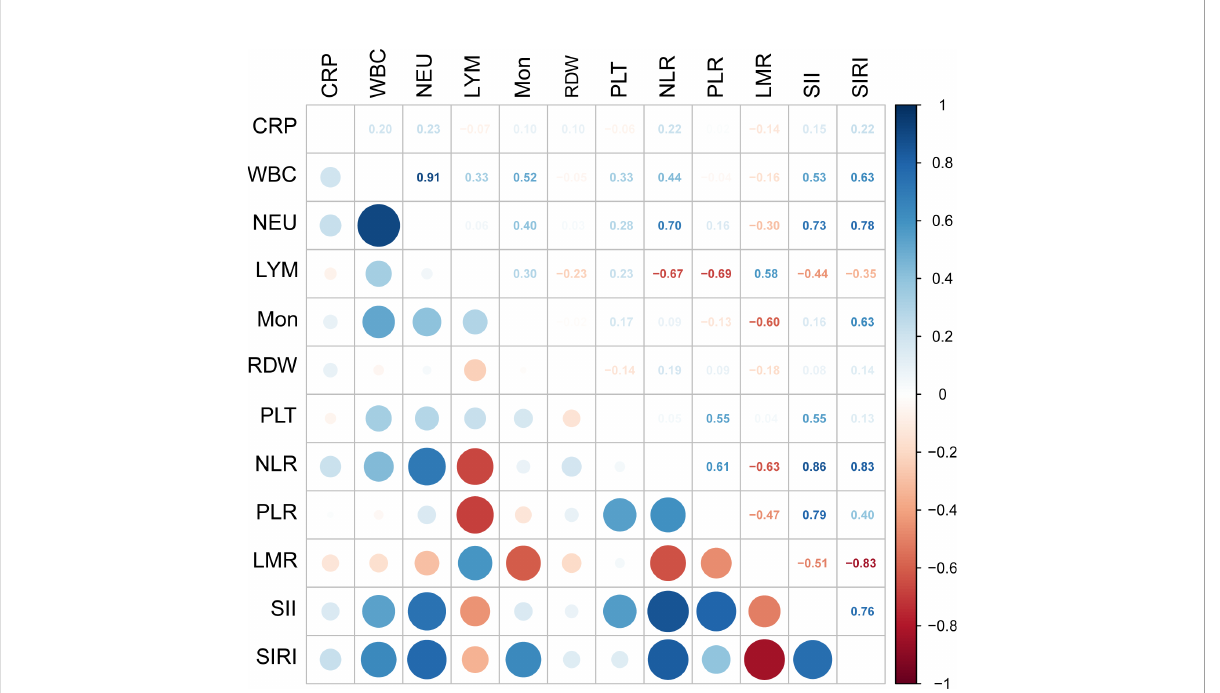
FIGURE 3 Pairwise pearson correlation coef fi cients among the 12 in fl ammatory markers. Blue indicates positive correlation, and red indicates negative correlation. Darker colors are associated with stronger correlation coef fi cients. CRP, C-reactive protein; WBC, white blood cell; NEU, neutrophils; LYM, lymphocyte; Mon, monocyte; RDW, red cell distribution width; PLT, platelet; NLR, neutrophil-to-lymphocyte ratio; PLR, platelet-to-lymphocyte ratio; LMR, lymphocyte-to-monocyte ratio monocyte; SII, systemic immune-in fl ammation index; SIRI, systemic in fl ammatory response